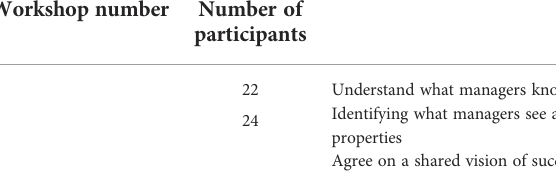
TABLE 1 Workshops details and